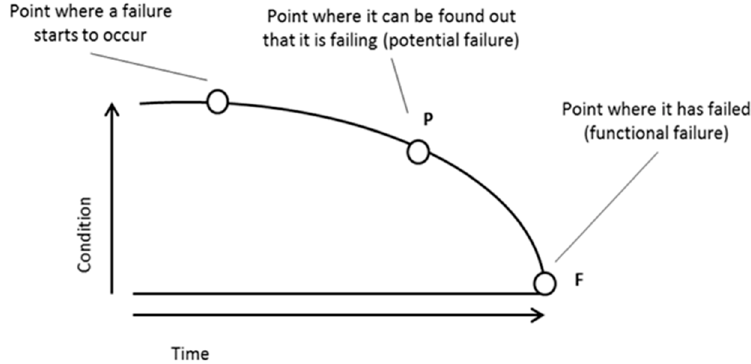
Figure 1. Potential Failure and Functional Failure (P-F) curve.